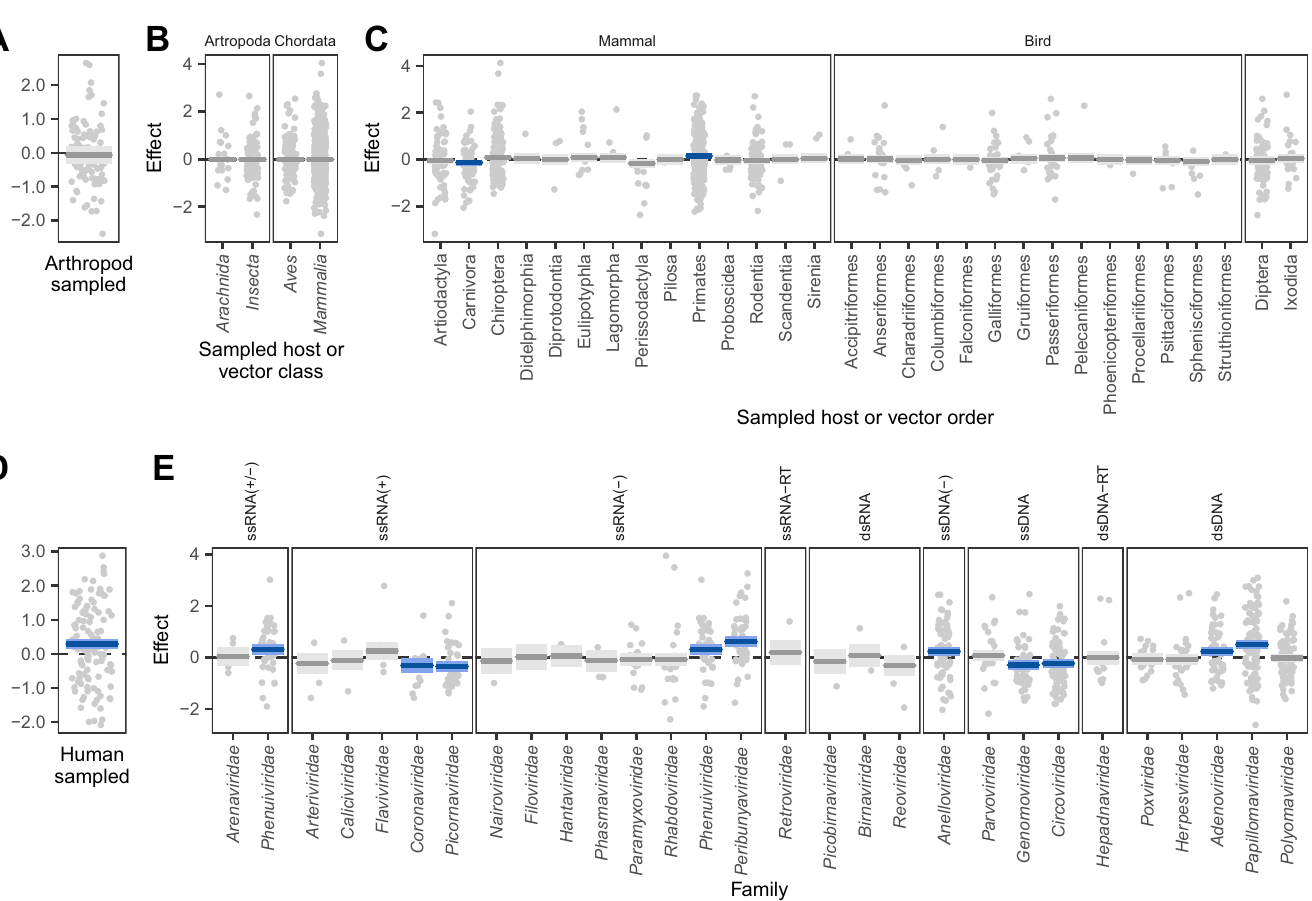
Fig 4. Factors correlated with the probability of human infection predicted from holdout viral genomes. Partial effects plots are shown for a beta regression model attempting to explain the mean probability assigned by the bagged model to all viruses in Fig 3A, accounting for whether or not the genome predicted was sequenced from arthropods (as opposed to chordates), (A) , random effects for the taxonomic class and order of sampled hosts (B and C) , whether the sequence derived from a human sample (D) , and a random effect for the virus family represented (E) . Points indicate partial residuals, while lines and shaded areas respectively show the maximum likelihood and 95% CI of partial effects. CIs that do not include 0 are highlighted in blue. CI, confidence